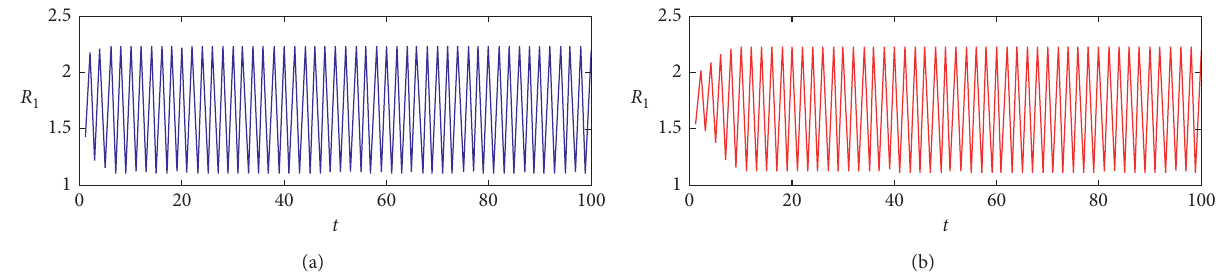
Figure 9: Orbits of R